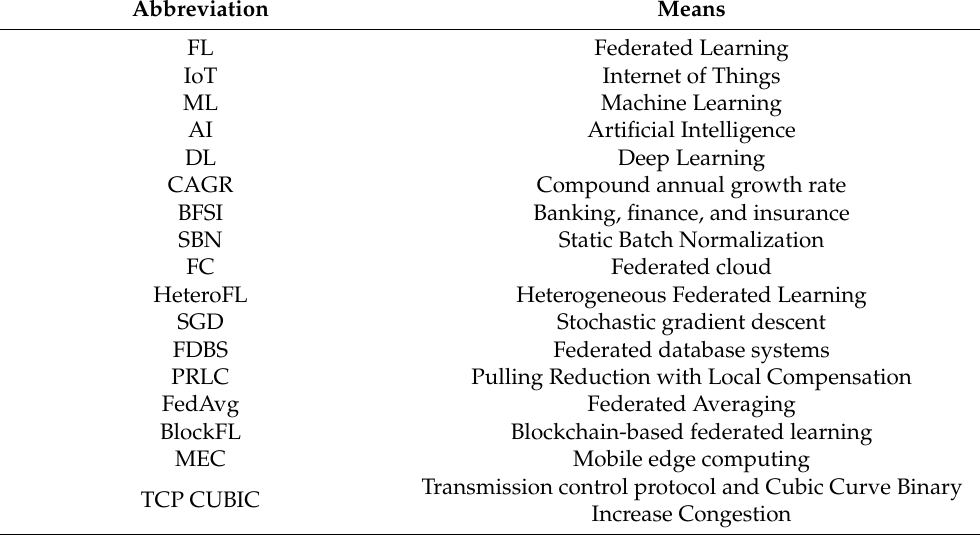
Table 1. List of